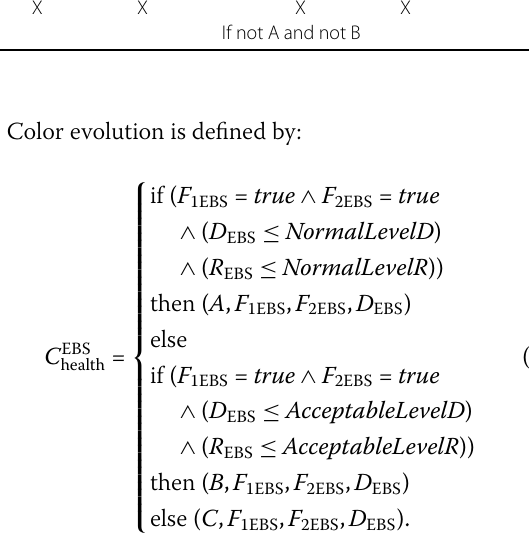
Table 3 Variables for the equipment level: EBS module Var F1 F2 D R1 1 0 1 0 2 1 0 2 1 0 A X X X X B X X X X B X X X X C If not A and not